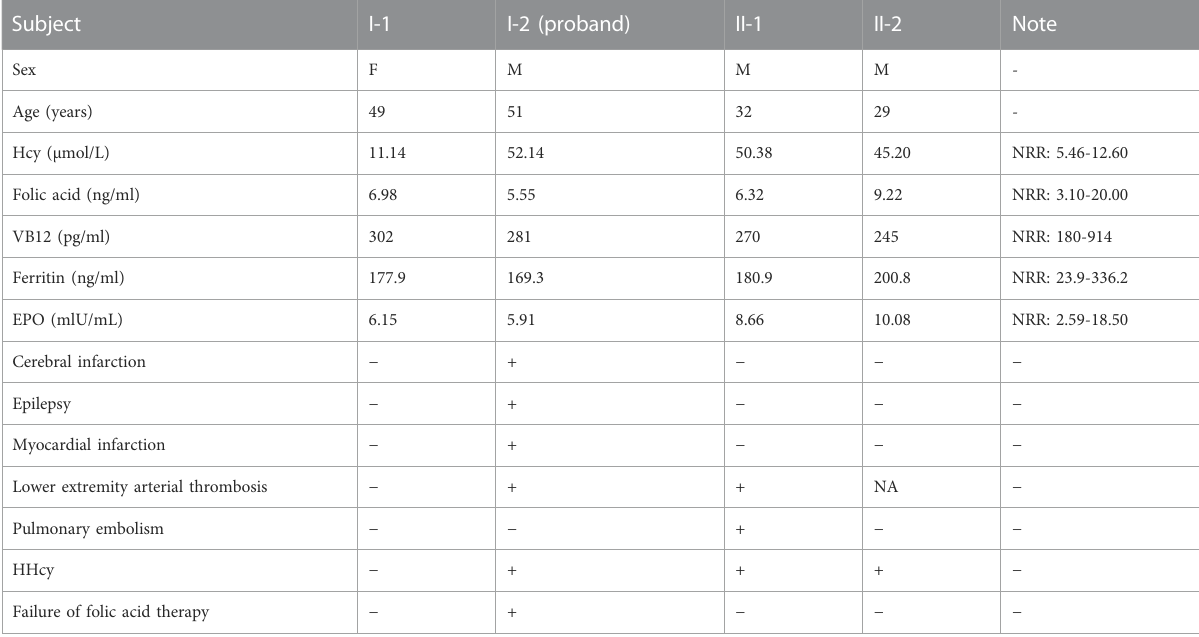
TABLE 1 Clinical data on the members in this